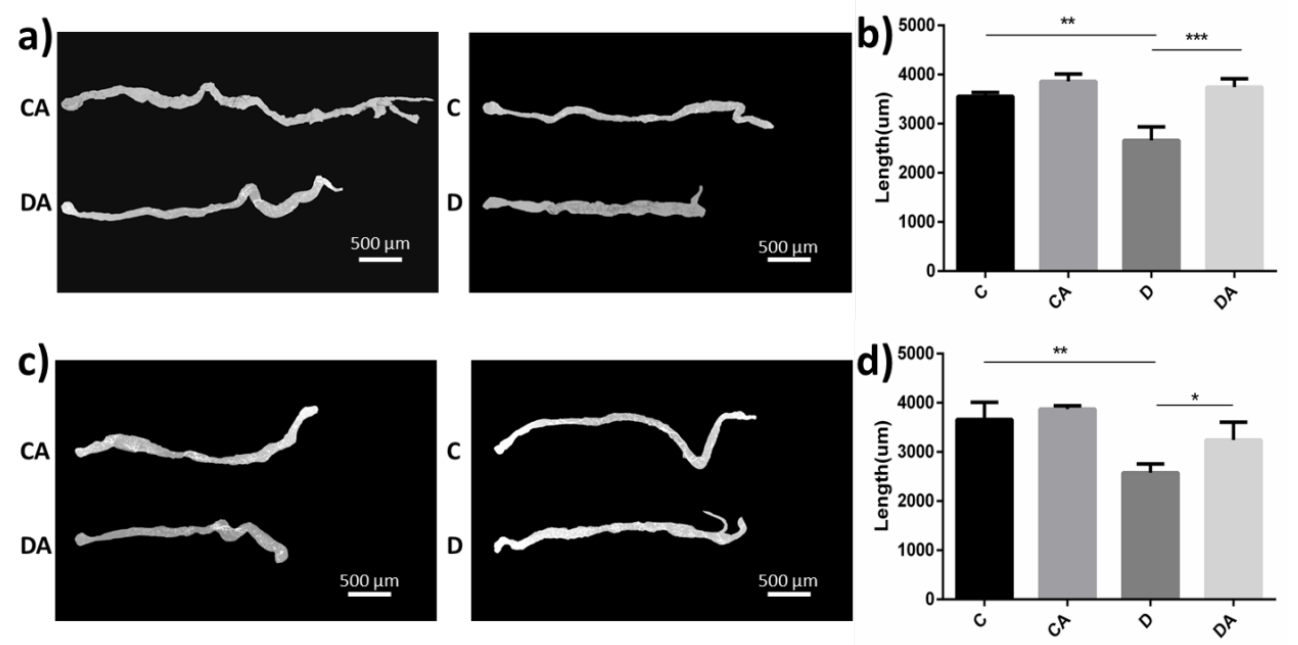
Figure 2. Effects of BANCs on the intestinal morphology of female D. melanogaster with DSS-induced inflammation. C, CA, D, and DA represent the blank control group, BANC control group, inflamed group, and BANCs + inflamed group, respectively. Intestinal morphology of normal ( a ) and axenic ( c ) female D. melanogaster in the four groups. The intestinal length of normal ( b ) and axenic ( d ) female D. melanogaster was measured using ImageJ software. Data from triplicate repetitions are expressed as the means ± SEMs. Statistical significance: * p < 0.05, ** p < 0.01, *** p < 0.001.